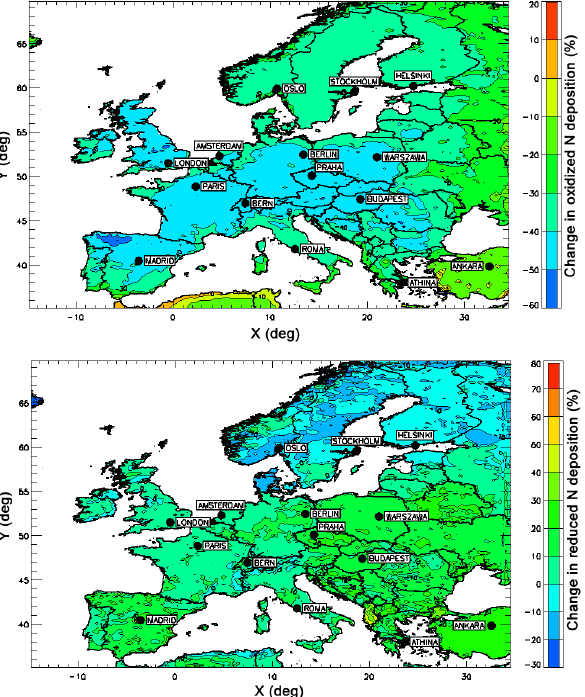
Figure 17. Relative changes in deposition of oxidized (upper panel) and reduced (lower panel) nitrogen species over the European do- main, BL